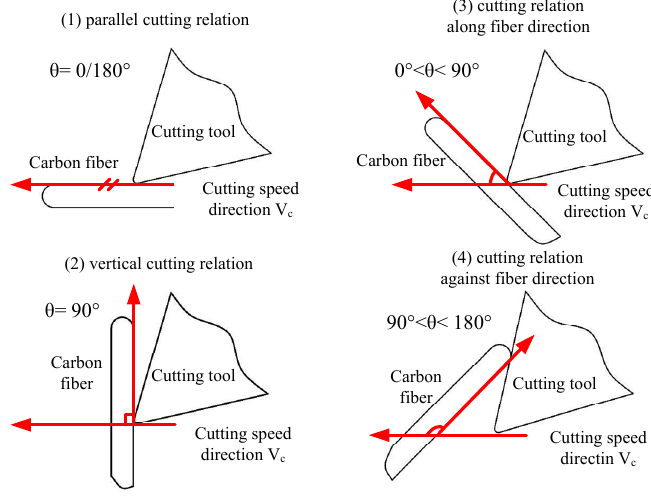
Figure 4. Cutting relationships between tool and carbon fiber.